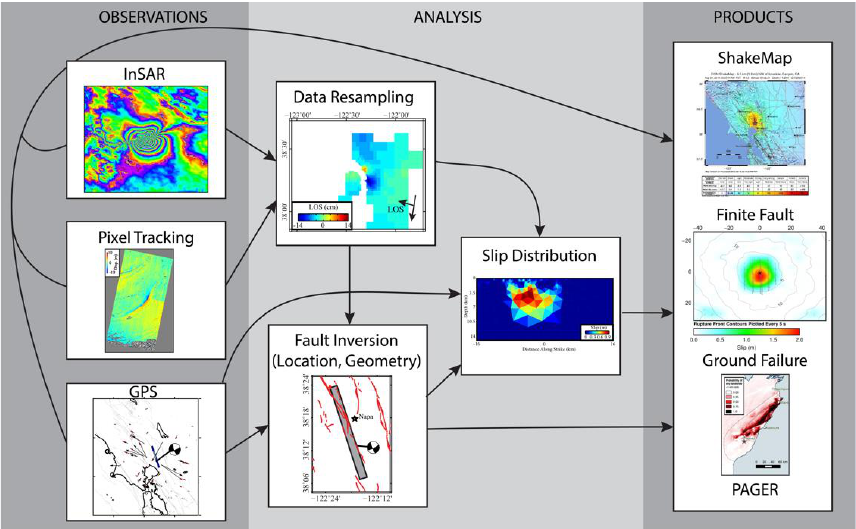
Figure 3. Illustration of the basic workflow of geodetic observation and analysis in NEIC response. Arrows indicate the different pathways of products and where observations and analysis products may be used to either directly inform NEIC response products or to further inform modeling efforts. The GPS and fault model examples are from the 2014 South Napa, California earthquake [7].